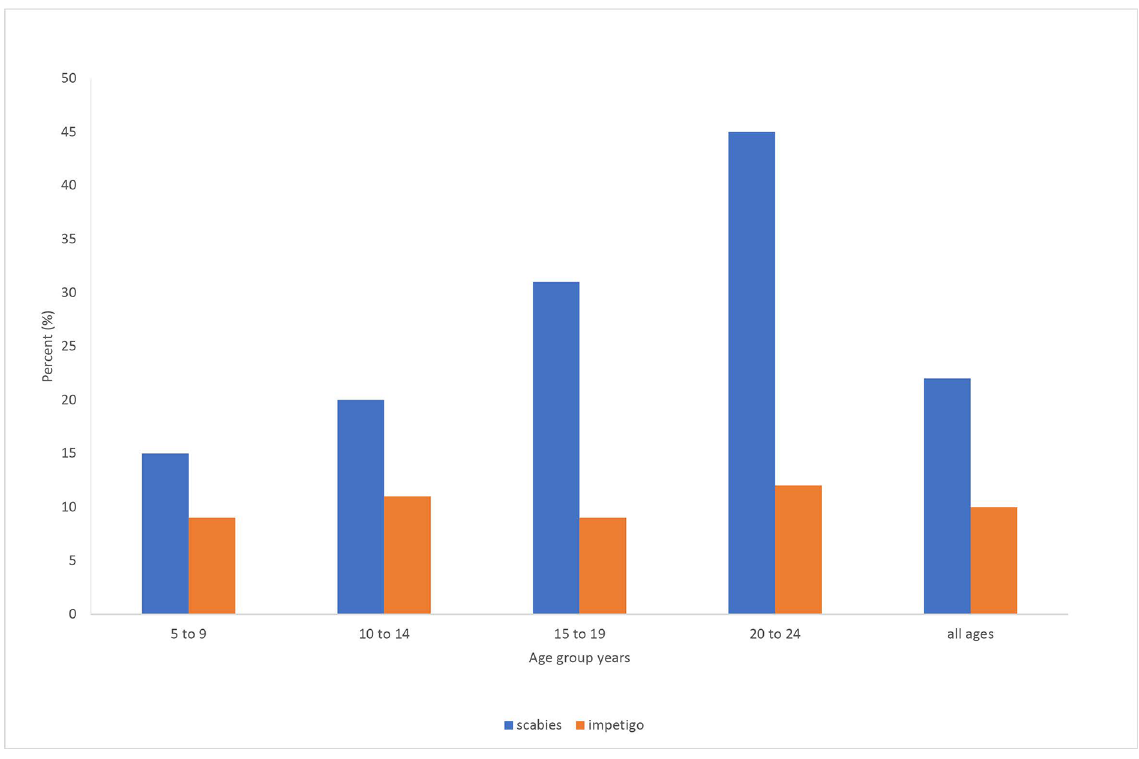
Fig 1. Prevalence of scabies and impetigo by age